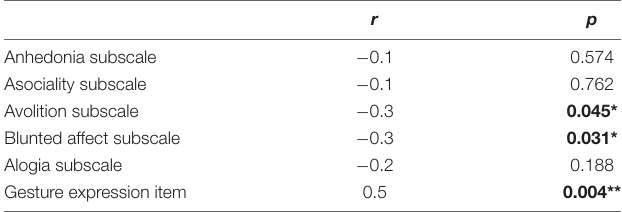
TABLE 3 | BNSS subscales/item correlations with PONS total score controlling for medication in patients.